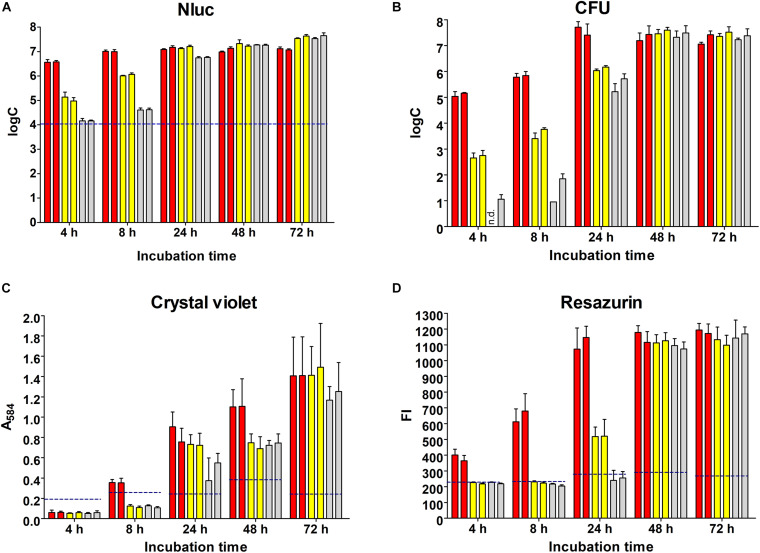
Monitoring of biofilm formation on polystyrene plates over 72 h using the Nluc bioluminescence assay (A), CFU counting assay (B), crystal violet staining (C), and resazurin fluorescence (D). Bars of the same color indicate biological repeats, each performed as three technical repeats. Different concentrations of L. innocua were inoculated to trigger biofilm formation (1.0 × 107 CFU/mL, red; 1.0 × 105 CFU/mL, yellow; 1.0 × 103 CFU/mL, gray). Error bars: standard deviation; horizontal dashed blue lines, limit of detection (Nluc) or minimal reliable signal (crystal violet, resazurin). FI, fluorescence intensity; n.d., no CFU on agar plates (i.e., <1 log CFU/mL).